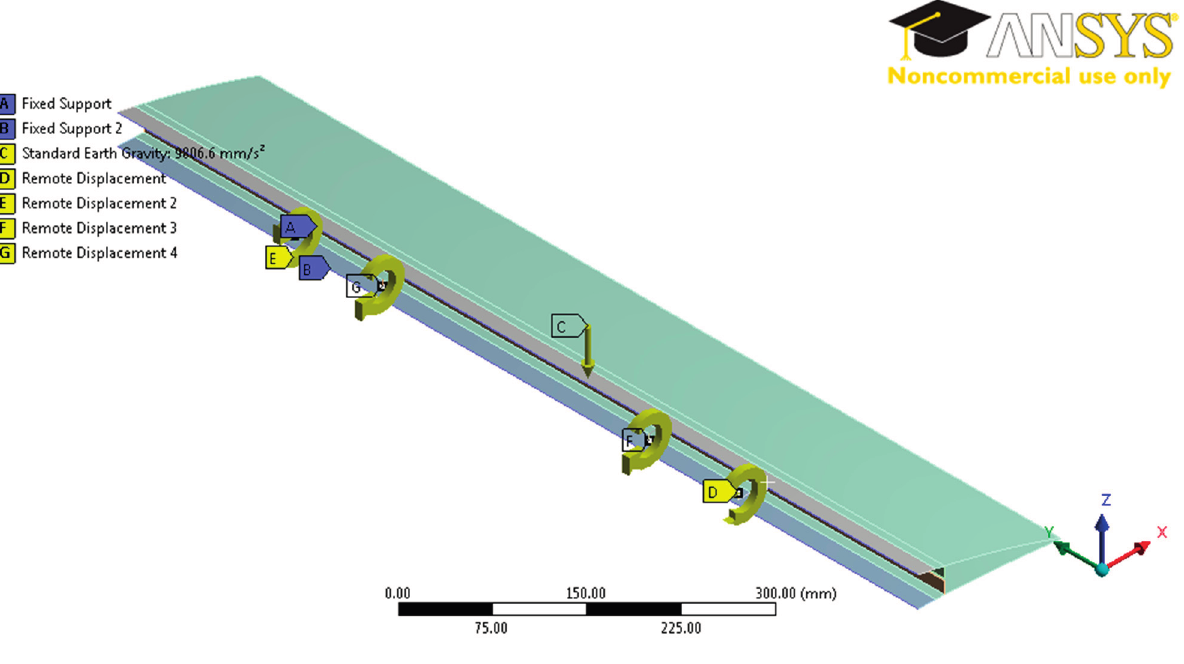
Figure 19. Boundary Condition applied to the leading edge of the rigid part.